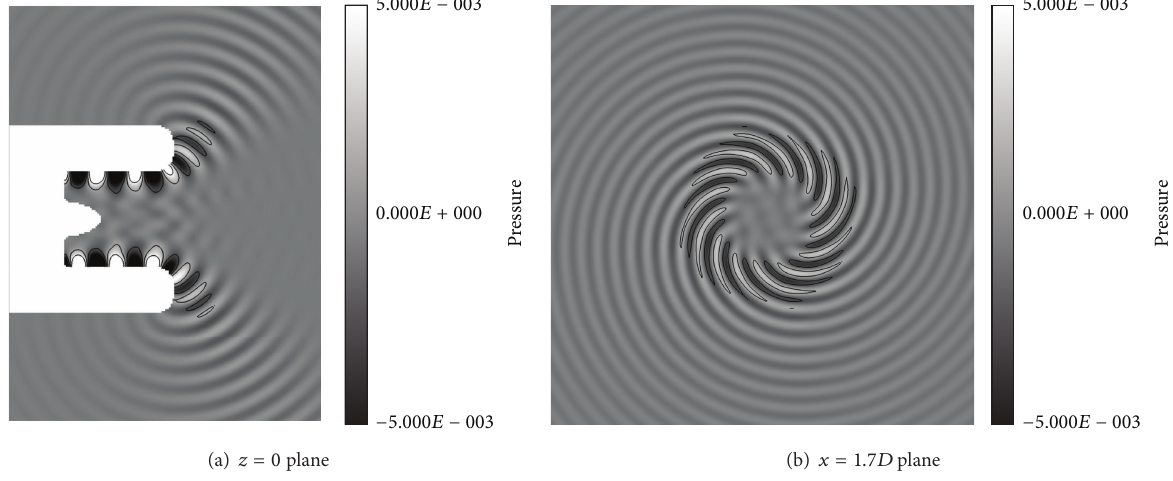
Figure 12: Instantaneous pressure distributions of two cross-sectional surfaces.